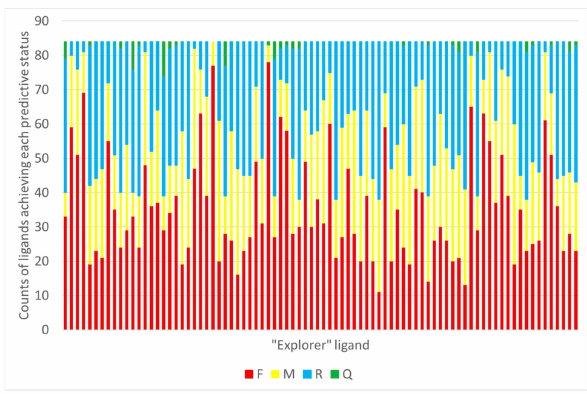
Figure 7. For each explorer ligand used to generate a CF-based RMSD landscape, this is challenged to predict RMSD of poses of remaining ligands. The status of each such prediction is assessed, and the total counts of Failed (F), Moderately successful (M), Ranking success (R) and Quantitative prediction RMSD success (Q) are reported on